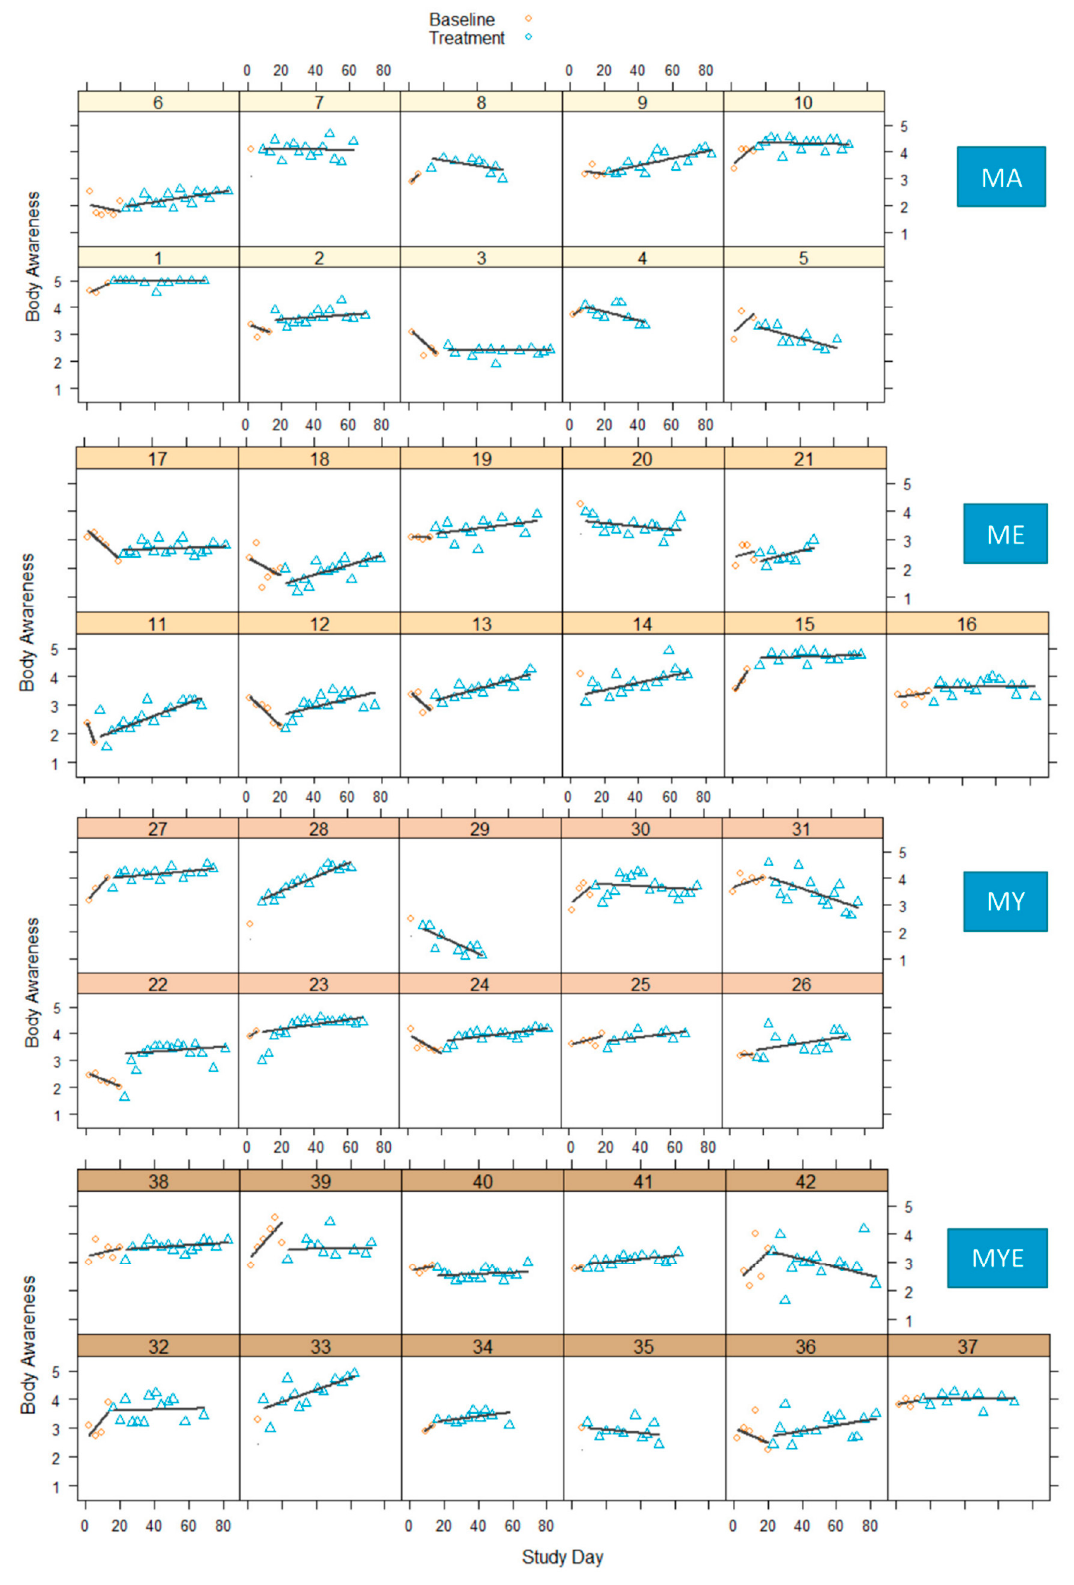
Figure 1. Body awareness scores in four conditions during baseline and treatment phases for each participant with regression lines for each phase. Note . MA = Mantra meditation only; ME = meditation and ethical education; MY = meditation and physical yoga; MYE = meditation, physical yoga, and ethical education.